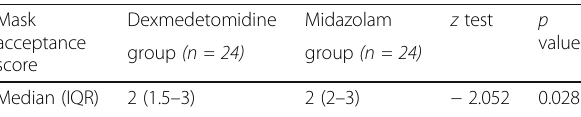
Table 10 Comparison between group D and group M as regards Mask Acceptance Score